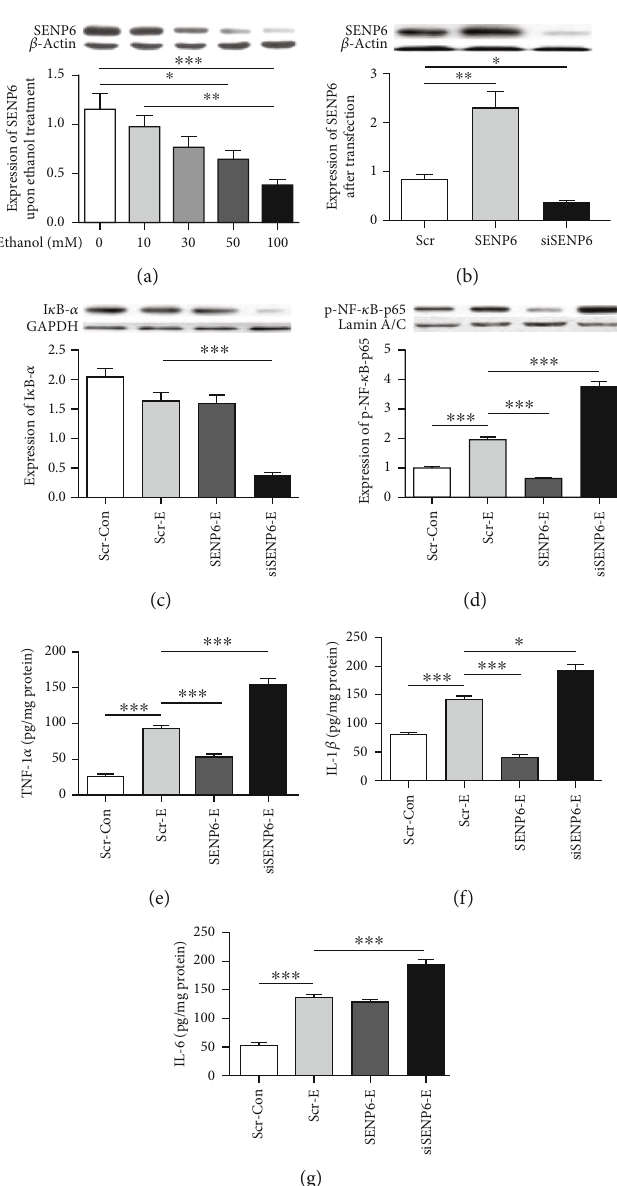
Figure 5: The modulatory e ff ect of SENP6 in ethanol-induced neuroin fl ammation. (a) The statistical analyses of SENP6 levels in cultured microglial cells treated with di ff erent doses of ethanol (0, 10, 30, 50, and 100mM) for 24h. (b) The transfection e ffi ciency by comparing the SENP6 level of the SENP6 and siSENP6 groups to Scr group. (c – g) The levels of IkB- α , p-NF- κ B-p65, TNF- α , IL-1 β , and IL-6 in microglial cells of the Scr group with nonethanol treatment and of Scr, SENP6, and siSENP6 groups after treatment with ethanol at100mM for 24h. Scr-Con=scrambled sequence group with nonethanol treatment; Scr-E =scrambled sequence group with 100mM ethanol treatment; SENP6-E=overexpressed SENP6 group with 100mM ethanol treatment; siSENP6-E=siRNA against SENP6 group with 100mM ethanol treatment. Quantitative analyses were normalized to β -actin (for SENP6), GADPH (for IkB- α ), or Lamin A/C (for p-NF- κ B-p65) for WB. And cytokine concentrations were normalized to the total protein content. Data are presented as the mean ± S : E : M . ∗ p < 0 : 05 , ∗∗ p < 0 : 01 , ∗∗∗ p < 0 : 001